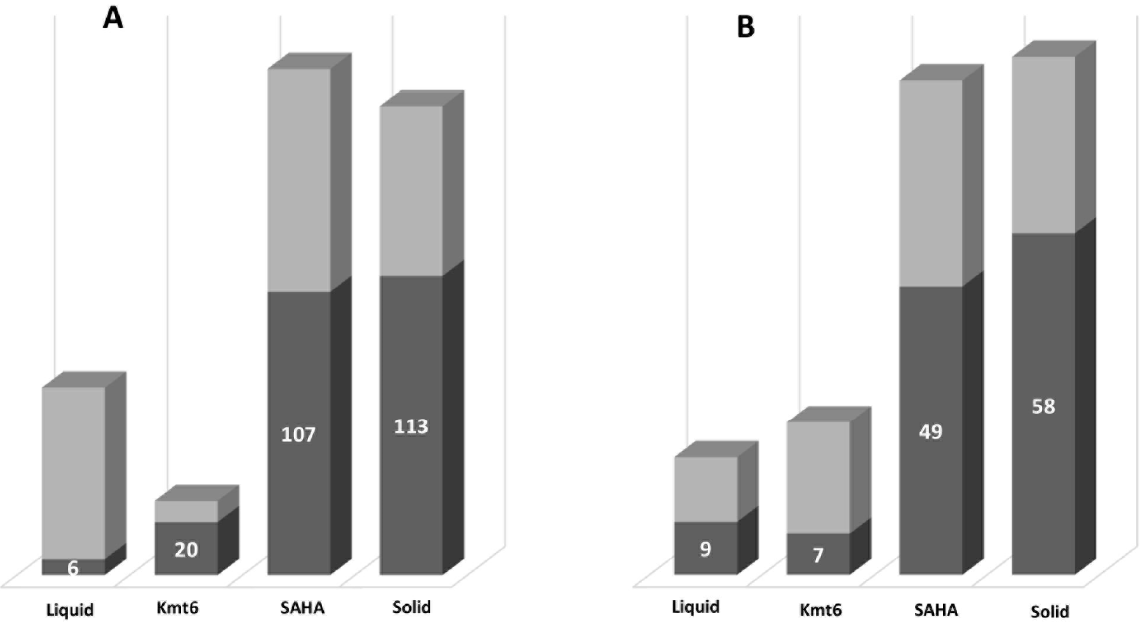
Figure 2. Number of “unique” features with significantly different means (in dark grey) among all previously detected as “unique” for each condition tested for SM production on P. anserina after 8 days of culture, according to a threshold of 1000 ( A ) and 15,000 ( B ) and a p value < 0.001 on ANOVA test. “Liquid”: M2 liquid medium inoculated with WT; “Solid”: M2 solid medium inoculated with WT; “SAHA”: M2 liquid medium supplemented with 100 μ M SAHA and inoculated with WT; Kmt6: M2 liquid medium inoculated with the Kmt6 mutant strain. All the experiments were performed in quadruplicates, except for the condition “Liquid” for which 8 replicates were performed.